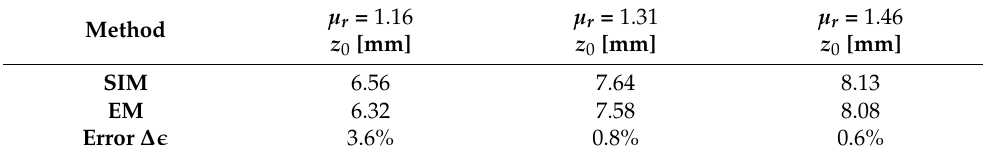
Figure 17. The PM’s equilibrium height calculated by EM. The results are given for three different values of the MF’s permeability, i.e., µ r = 1.16, µ r = 1.31, and µ r = 1.46, respectively. The mini-mum value on the individual curve is indicated with the Asterisk (*). Each of the curves was normalized by its maximum value. Table 4. The impact of the MF’s relative permeability ( µ r ) on the PM’s equilibrium height.